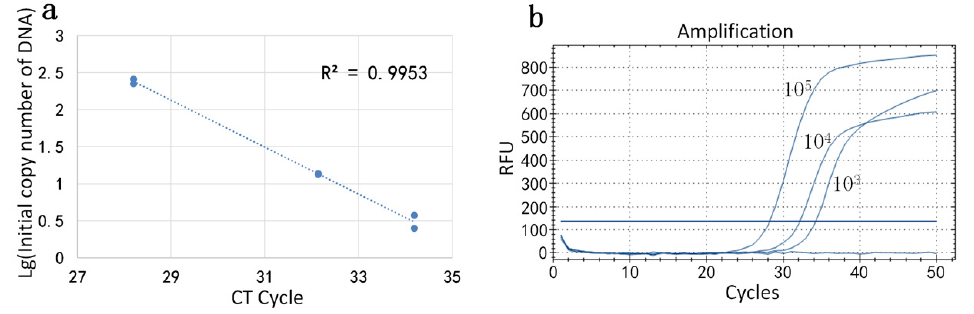
Figure 7. ( a ) Standard curve of the second set of high, medium, and low concentration reagents measured by our device. ( b ) Standard curve of the second set of high, medium, and low concentration reagents measured by commercial qPCR (BIO-RAD CFX Connect).